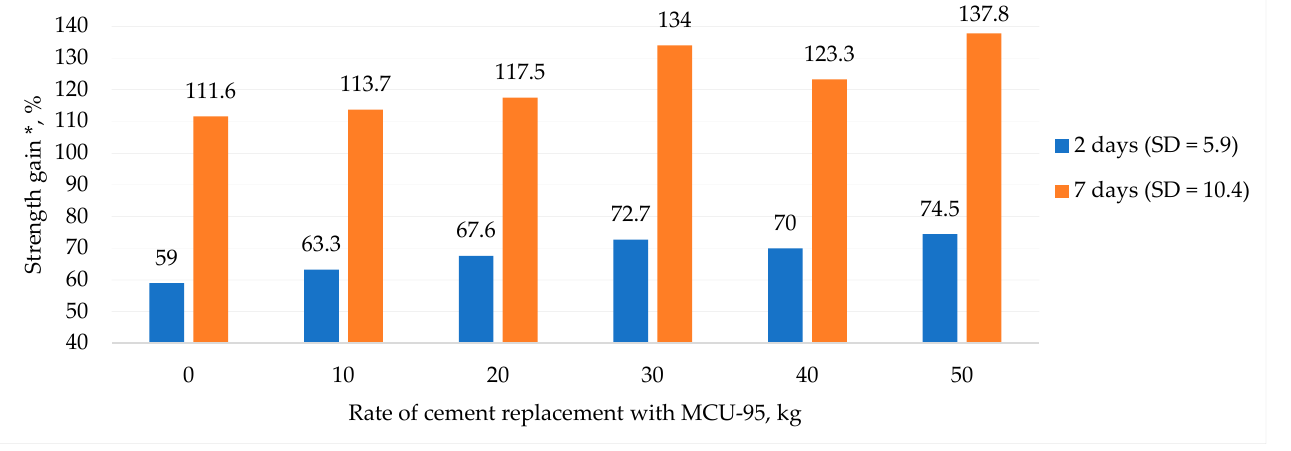
Figure 4. The effect of MCU-95 microsilica on strength gain. * For 100%, the average compressive strength of 30.0 MPa of the RHC reference composition of grade C 25/30 was used [35].